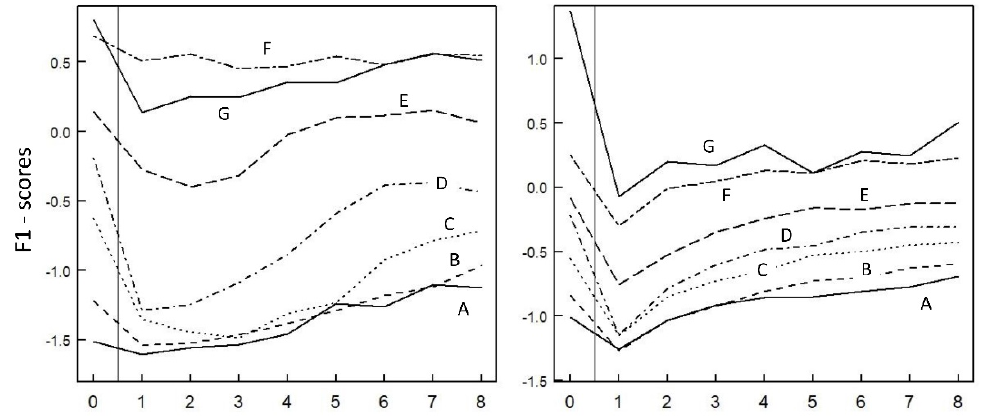
Figure 9. ( left ). Recovery rate of the avifauna after fire in seven vegetation types (from grassland (A) to cork oak (F) and holm oak forests (G); see Figure 2, measured by the mean shifts of samples on the first axis of the correspondence analysis of the bird matrix ( y − axis). X − axis: years after fire; the abscissa 0 corresponds to the prefire situation. ( Right ) Recovery rate of the vegetation, based on the correspondence analysis of the vegetation cover matrix. In class G, not sampled before the fire, the prefire values are those of controls.